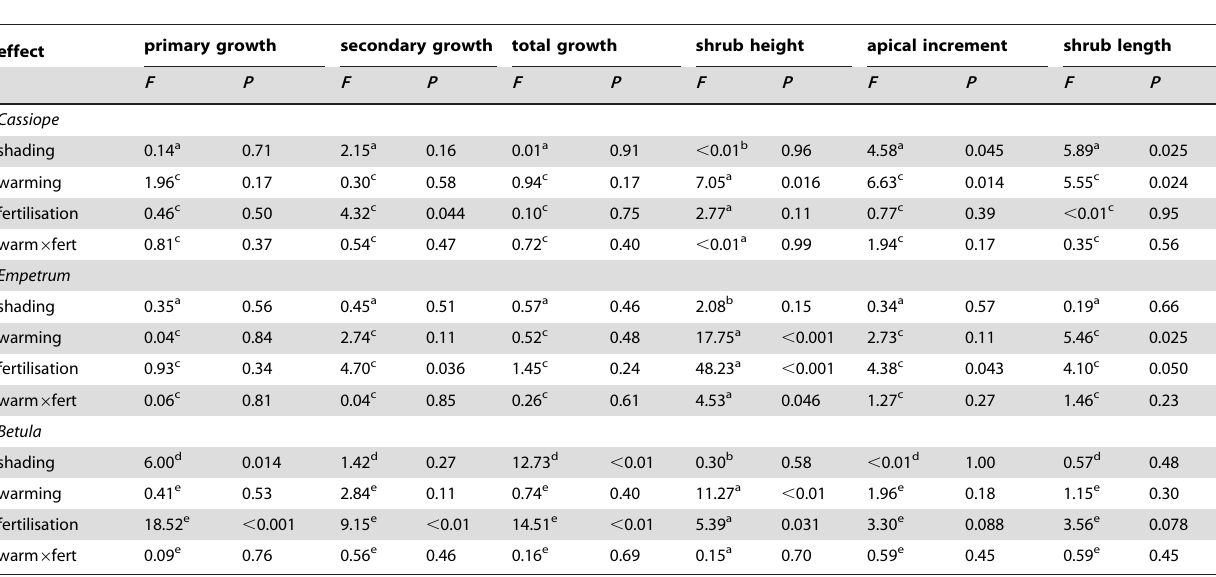
Table 1. Results of ANOVAs on the growth rates (primary, secondary and total), shrub height, apical (current year’s stem) increment and shrub length of the shrubs Cassiope tetragona , Empetrum hermaphroditum and Betula nana at a subarctic heath in Abisko (Northern Sweden) after 22 years of environmental manipulation.